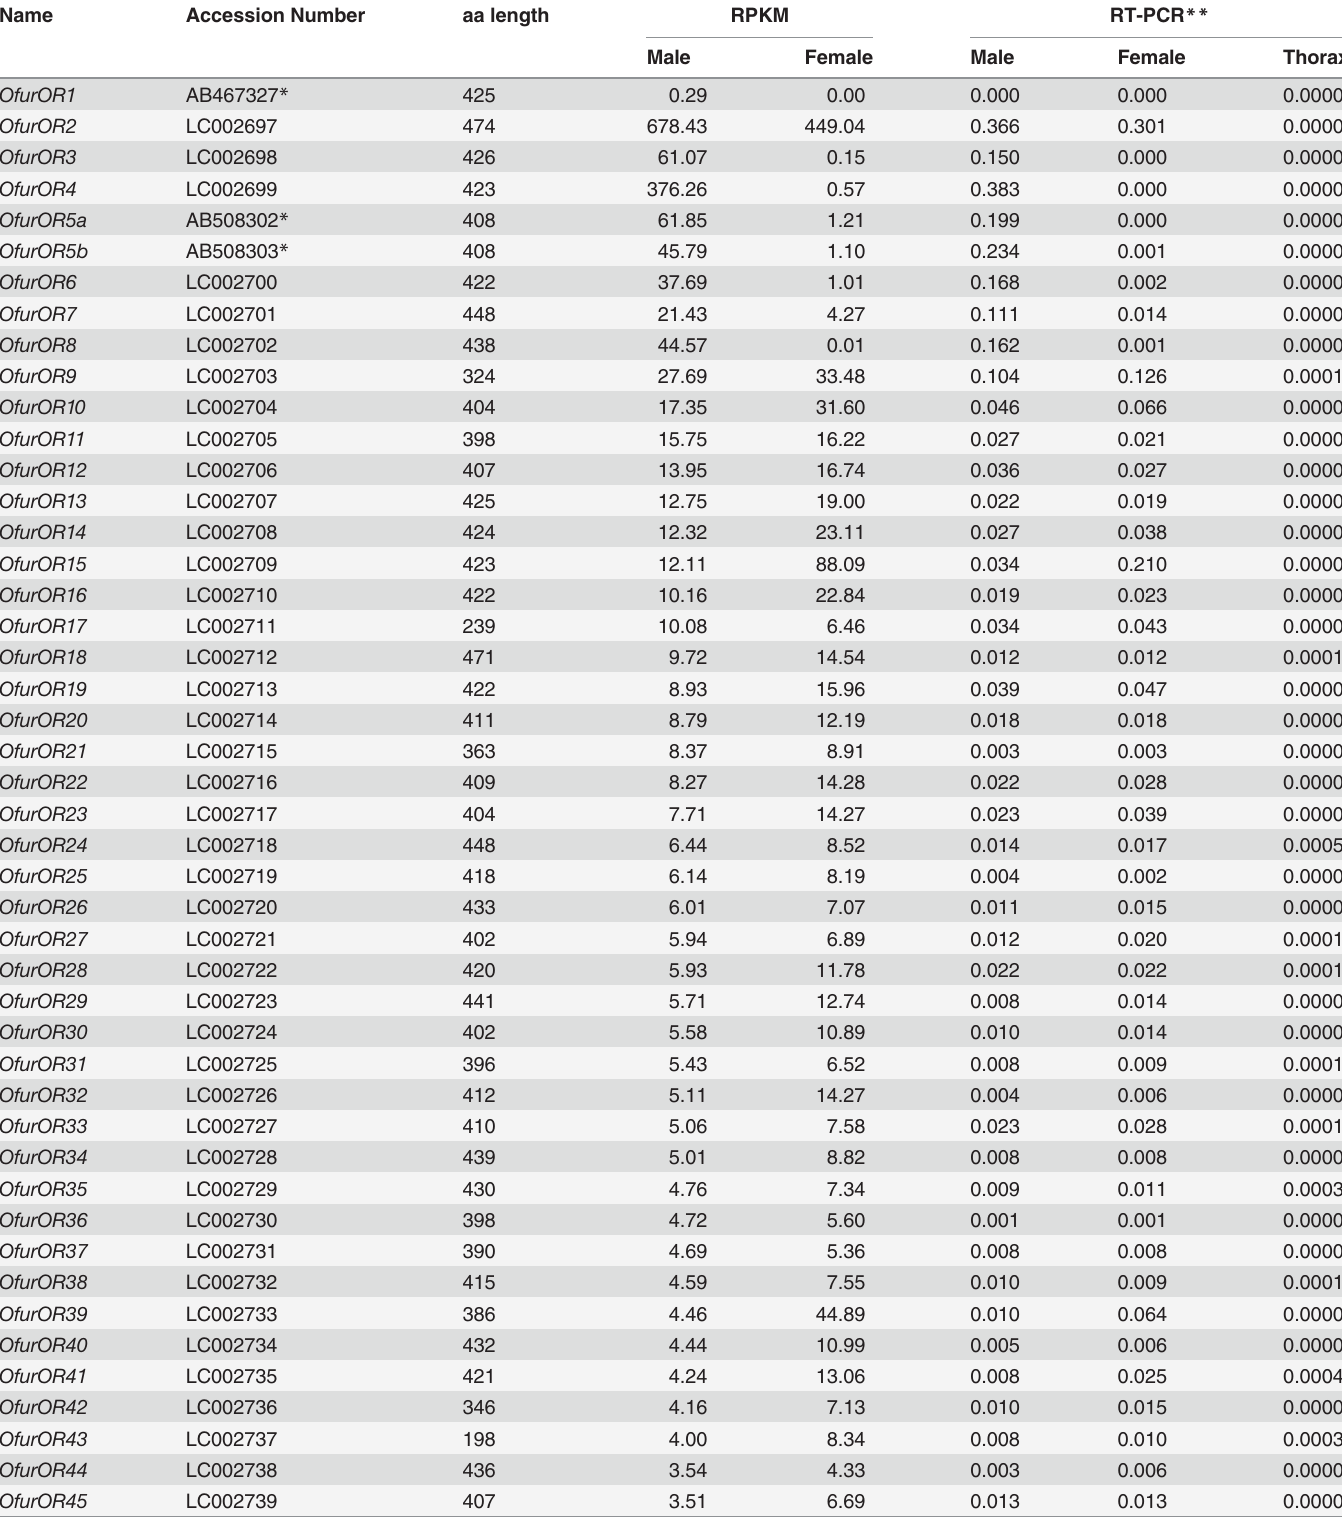
Table 5. List of candidate odorant receptors in O . furnacalis